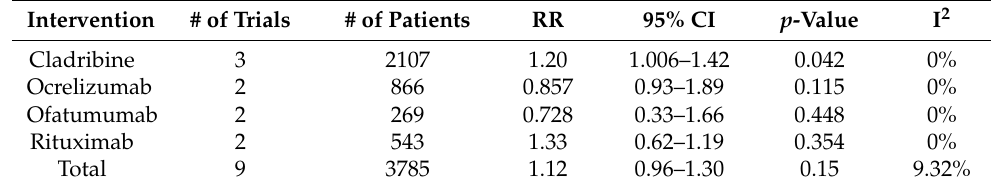
Table 2. Main characteristics of study results by intervention. Intervention # of Trials # of Patients RR